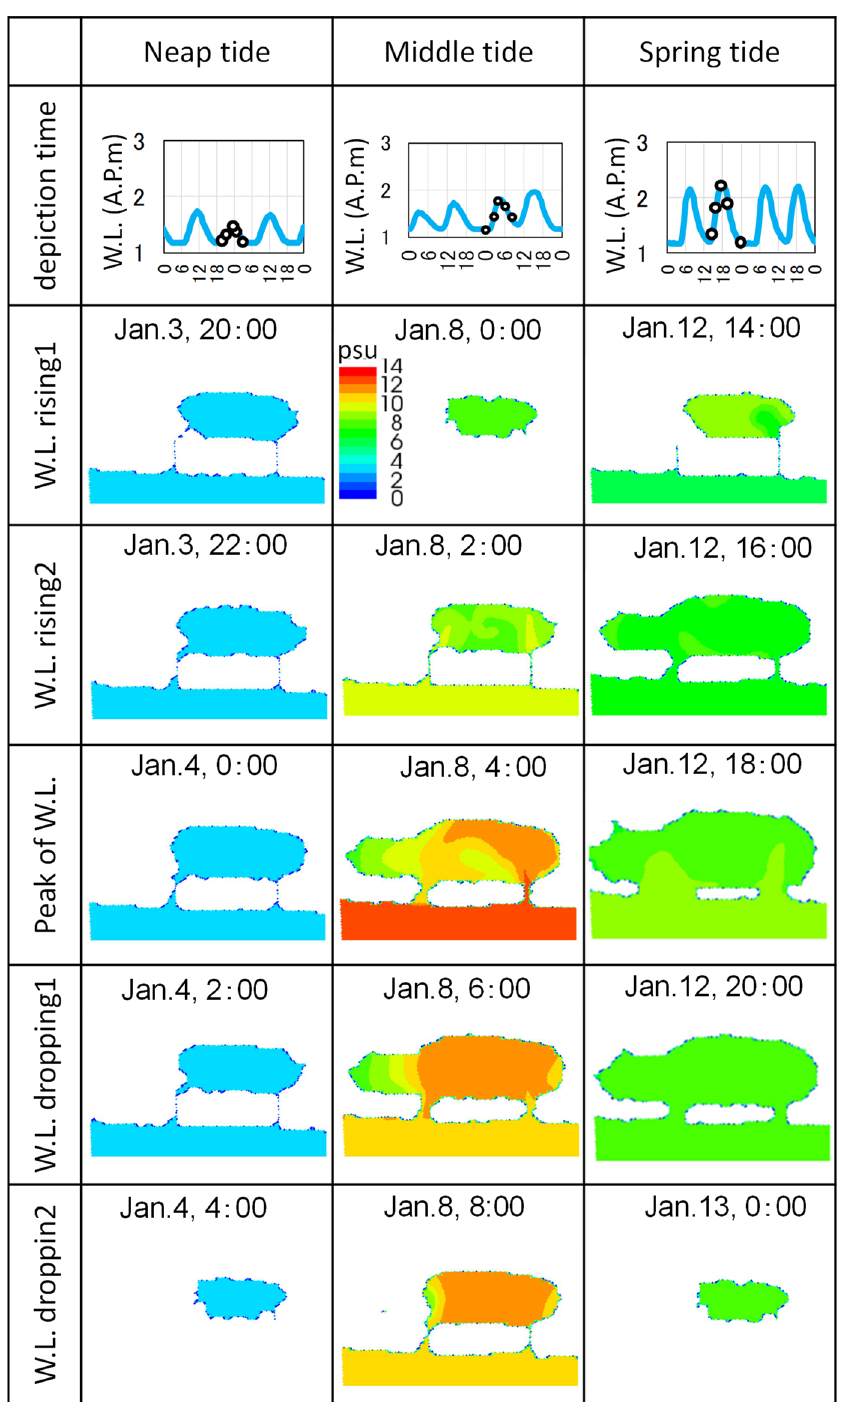
Figure 10. Horizontal distribution of salinity at